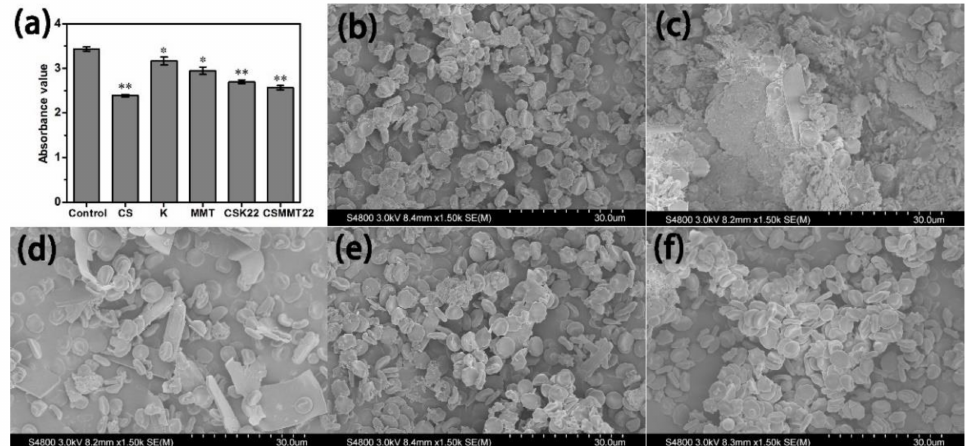
Figure 6. ( a ) RBC adhesion of Control, CS, K, MMT, CSK22, and CSMMT22. Data represent the mean ± SD ( n = 3). * p < 0.05; ** p < 0.01 compared to Control. SEM images of ( b ) CS, ( c ) K, ( d ) MMT, ( e ) CSK22, ( f ) CSMMT22.